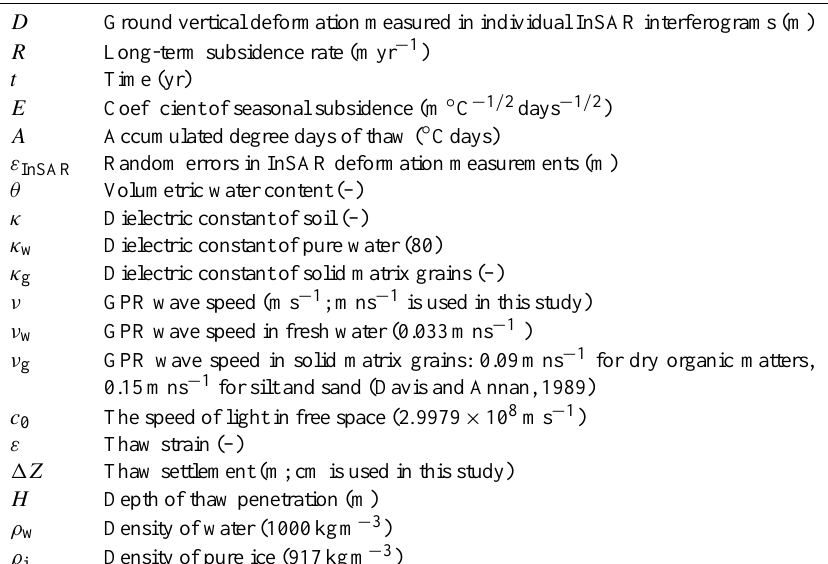
Table A1. Notation and